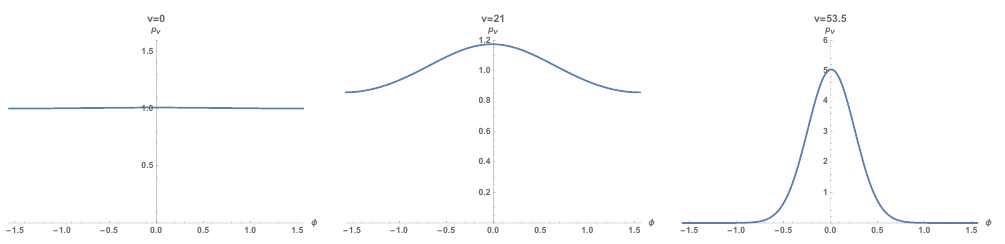
Figure 9 . Dynamical evolution of a perturbed EGB black ring near y = (cid:0) 1 =R , with m = 2, m=R = 0 : 5 and ~ (cid:11) =